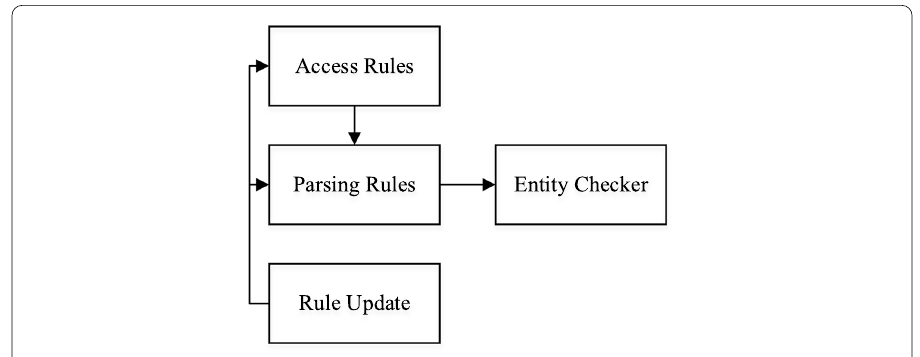
Fig. 3 The workflow of rule